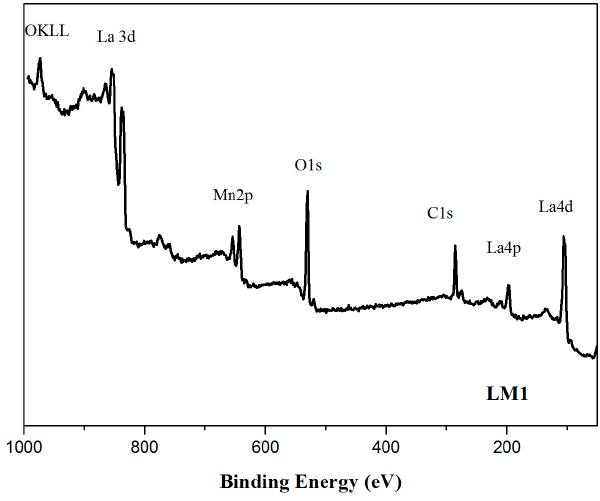
Figure 6. X-ray photoelectron spectroscopy (XPS) survey spectrum recorded for sample LM1.